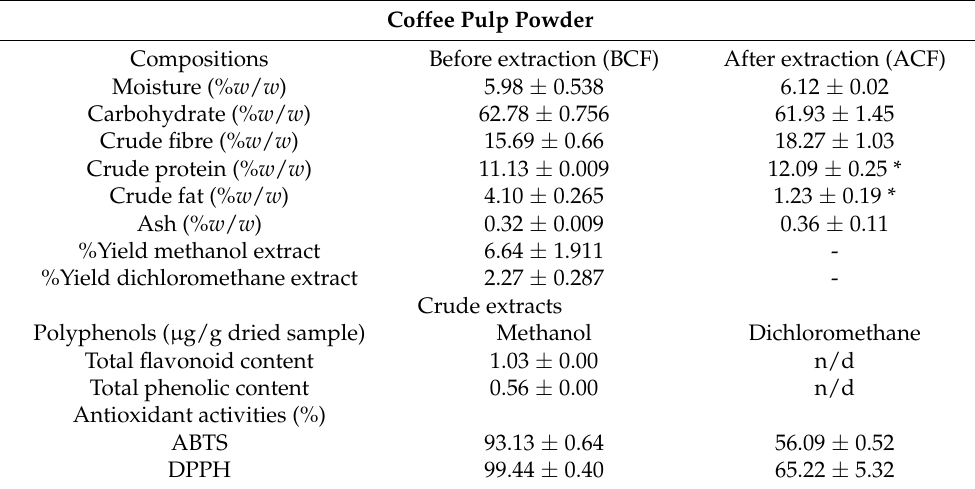
Table 1. Phytochemical compositions of coffee pulp